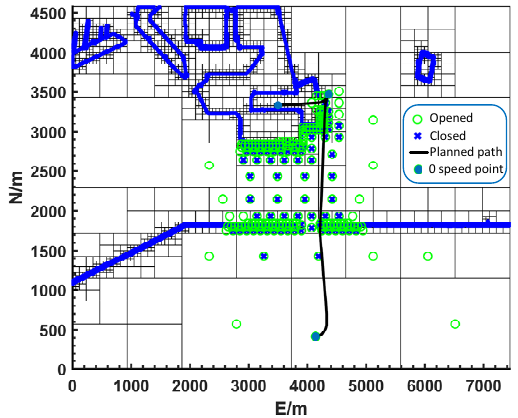
Figure 15. Path planned with backward motion.